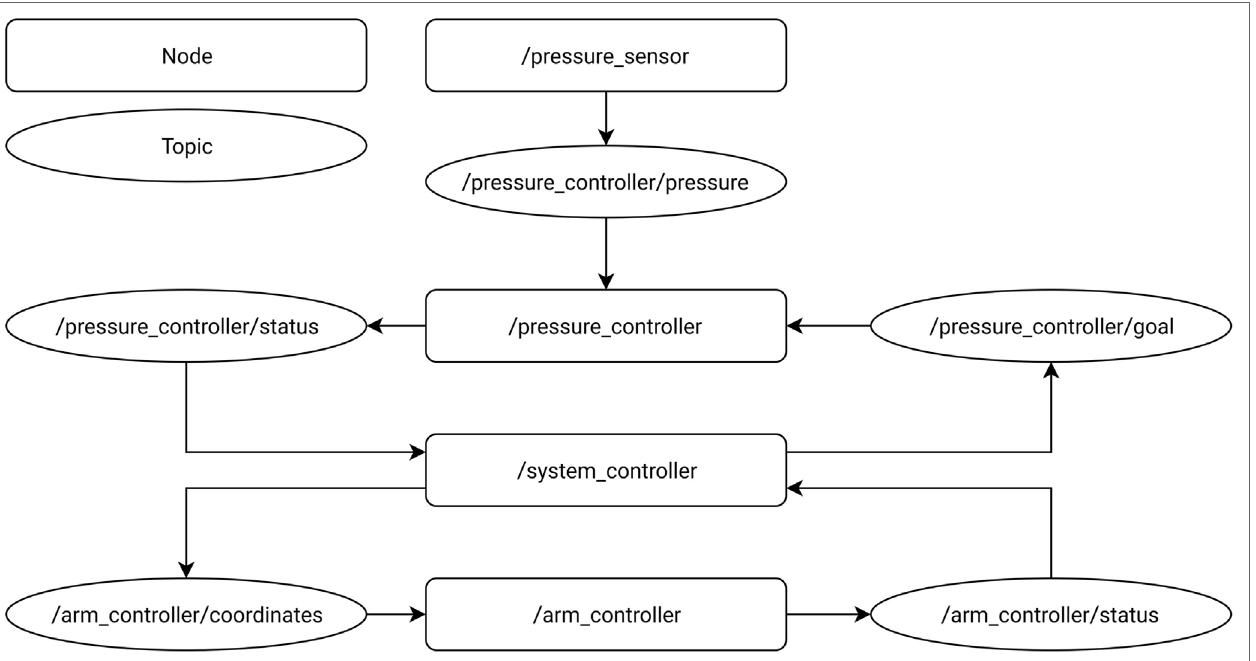
FigUre 2 | A graph showing the organization of ROS nodes and topics used to control the system. The soft robotic control is in the top half while the bottom half is the arm